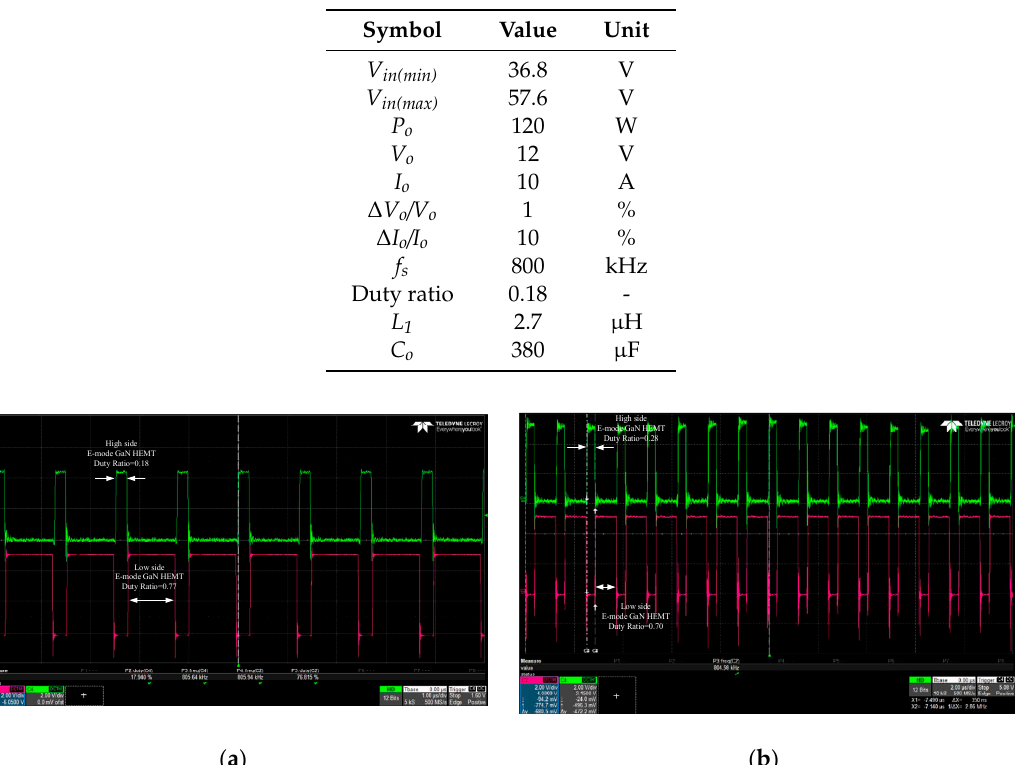
Table 3. Experimental parameters of Figure 9.